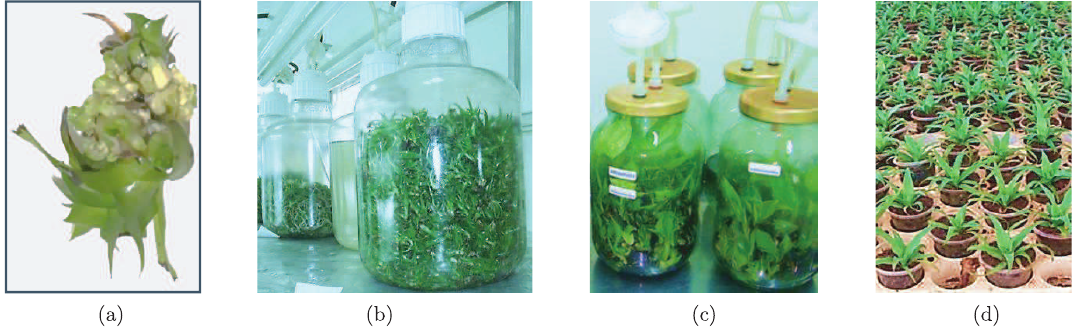
Figure 3. Phases inside and outside TIBs: ( a ) multiplication: typical shoots; ( b ) elongation: commonly produced into containers of high volume; ( c ) rooting: previous phase before carrying a plant to field; and ( d ) acclimatization: final phase where plants adapt to the environment (i.e., outside the